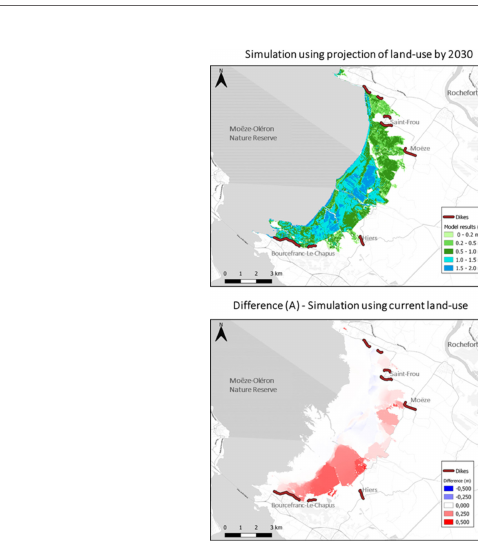
FIGURE 7 | Maximum heights simulated taking into account: (A) regional SLR projection by 2030, the P3 proposition and land-use projection by 2030; (B) same as (A) by 2050; (C) difference between (A) and simulations using current land-use by 2030; (D) same as (C) by